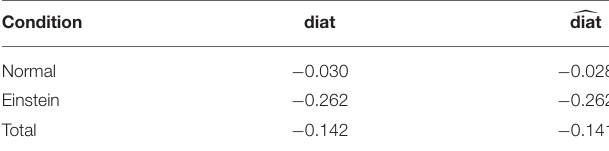
TABLE 4 | Means of the Observed diat and Estimated Values posterior distribution. Condition diat